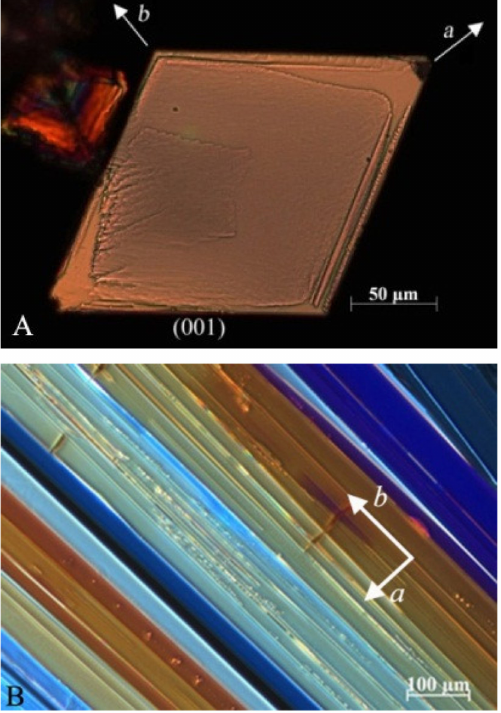
Figure 1. Polarized optical microscope images of flat crystal of 3Ph with exposed (001) face ( A ) and of directionally crystallized flat BA crystals ( B ). BA crystals are elongated and aligned with the b axis parallel to growth front direction. BA single crystals with various thicknesses lead to different colors under polarized light